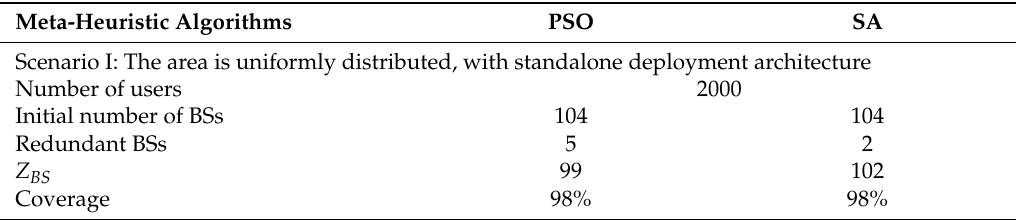
Table 4. Performance comparison (PSO vs. SA) in di ff erent user distribution for 5G network planning at 28 GHz.